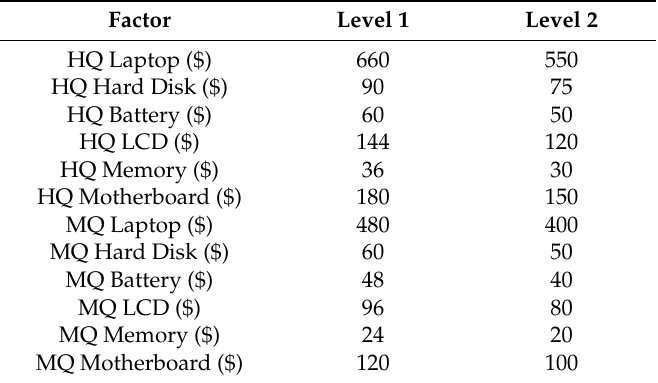
Table 1. Remanufactured laptop, subassembly, and component prices.